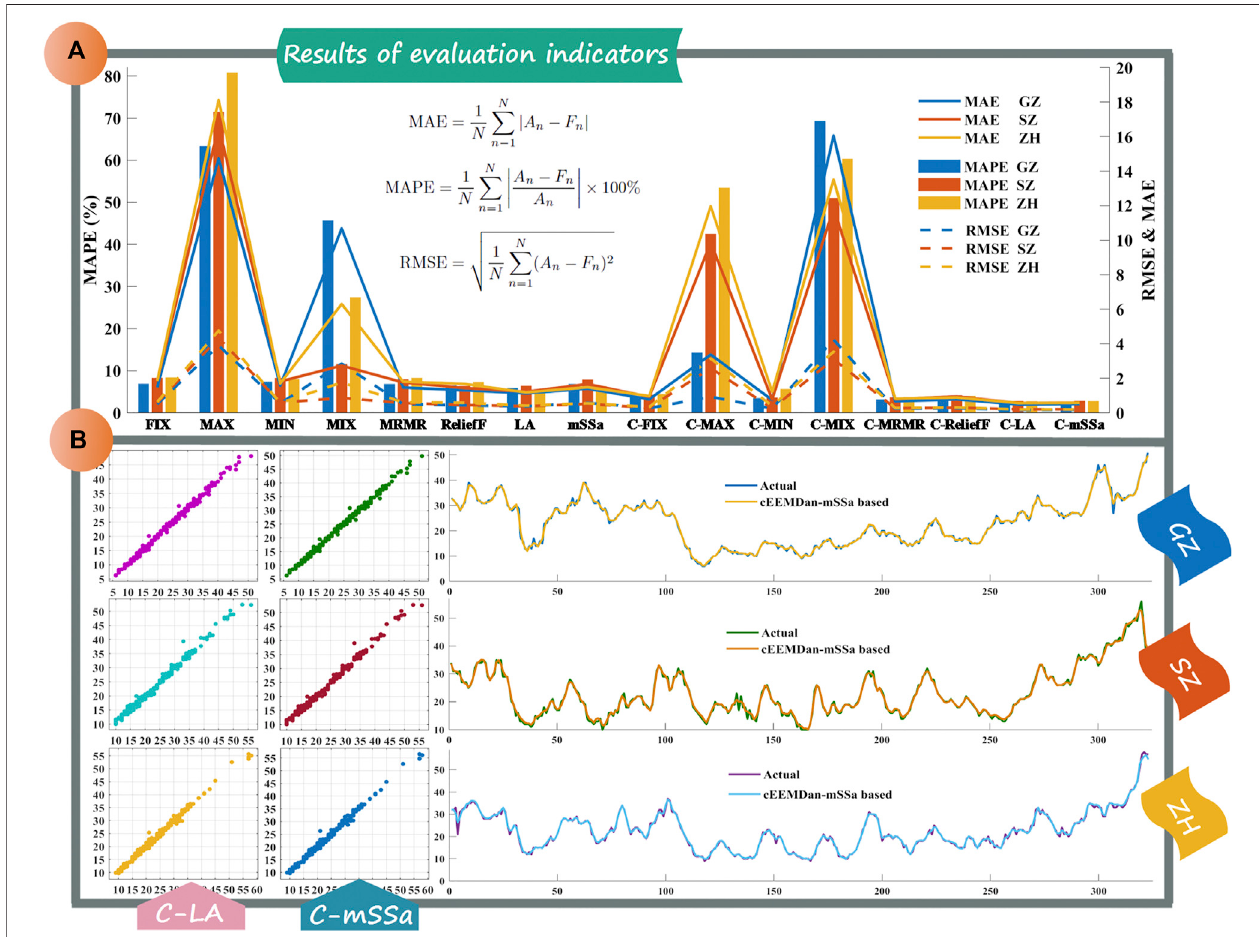
FIGURE3| Theforecasting resultsofthedifferentcombined methods. (A) istheresultsofevaluationindicatorsofthreestudycities. (B) istheforecastingresultsof C-LA and C-mSSa, where “ C- ” represents the cEEMDan.